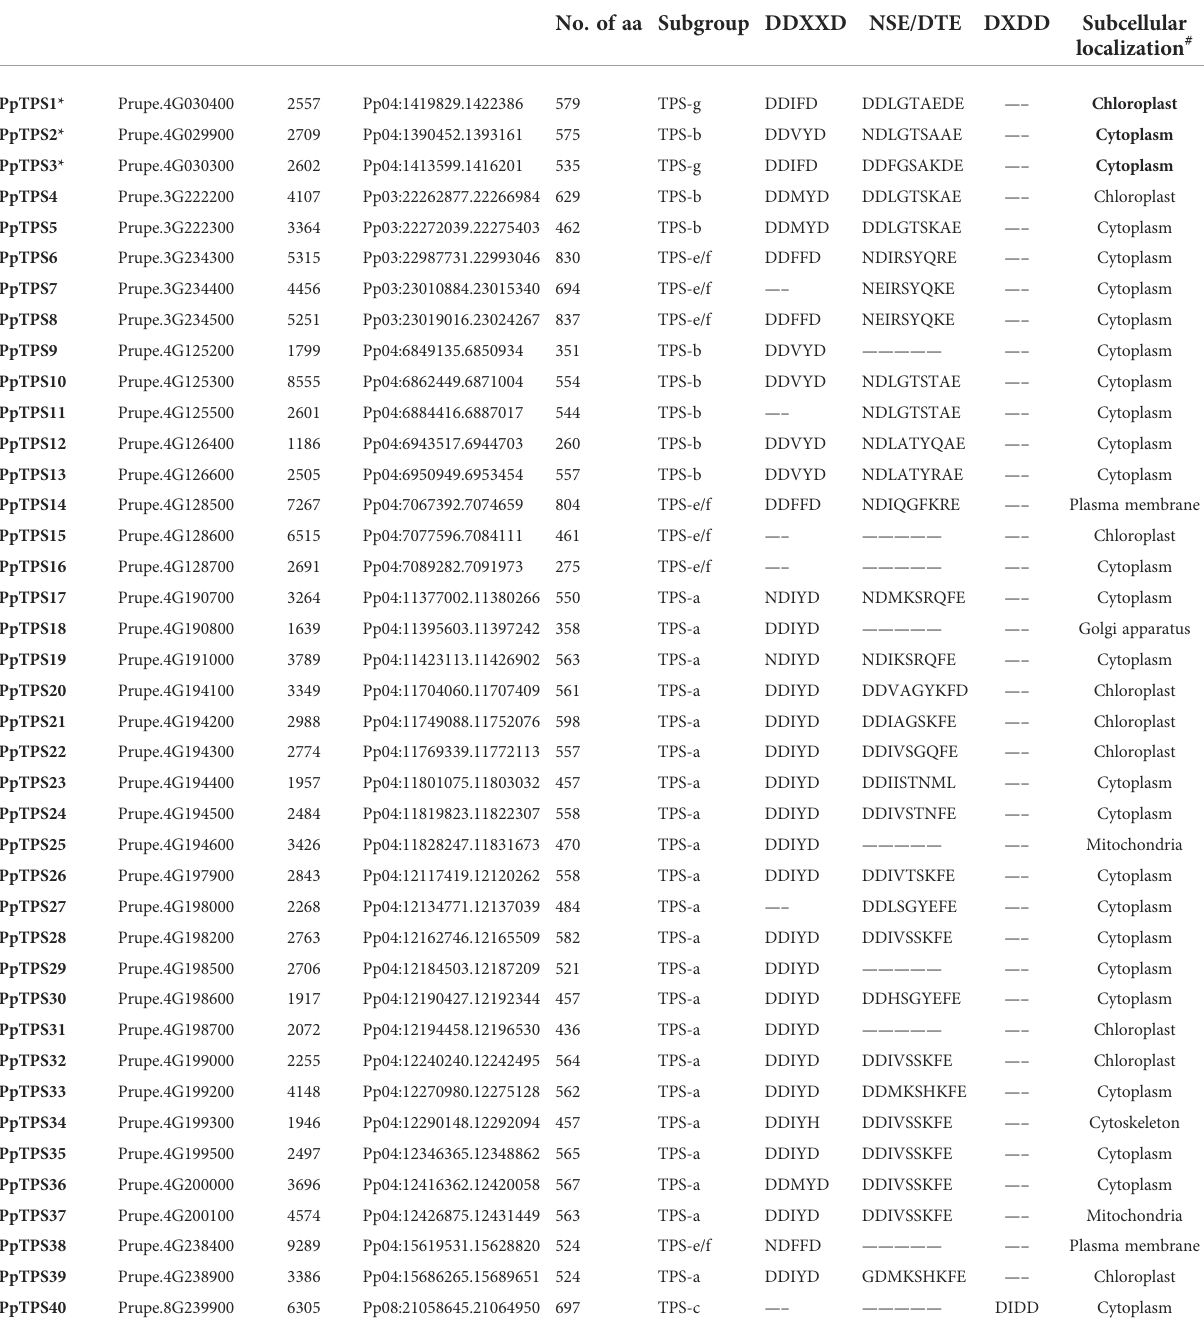
TABLE 1 Information of terpene synthase genes in peach ( Prunus persica